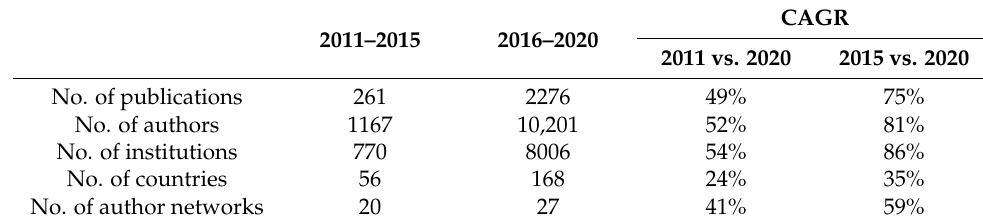
Table 1. Bibliometric indicators analyzed for AMR-related publications, 2011–2020.